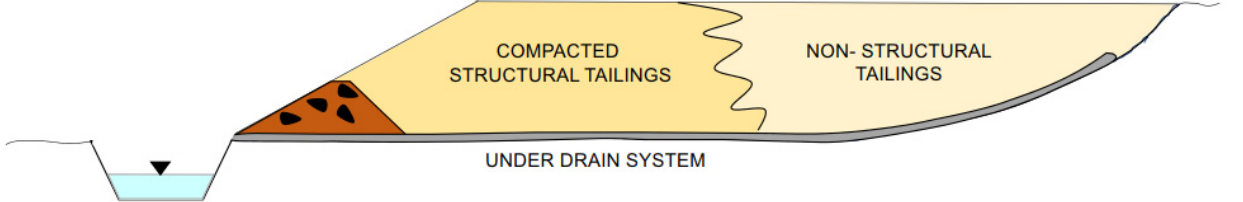
Figure 76. Chungar Filtered TSF Disposal Strategy.